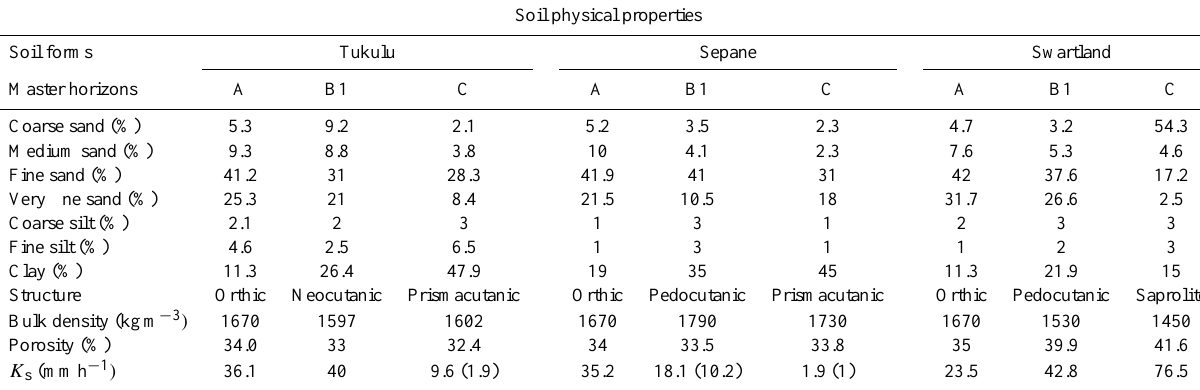
Table 1. Summary of the physical characteristics of the three soil